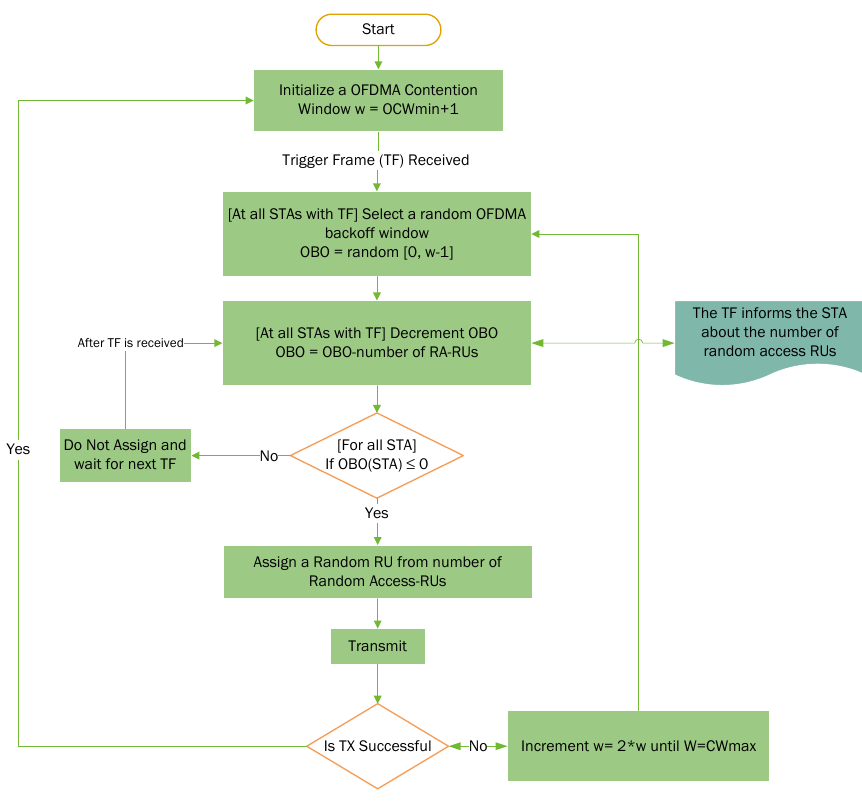
Figure 3. UORA operation for random access in UL-OFDMA